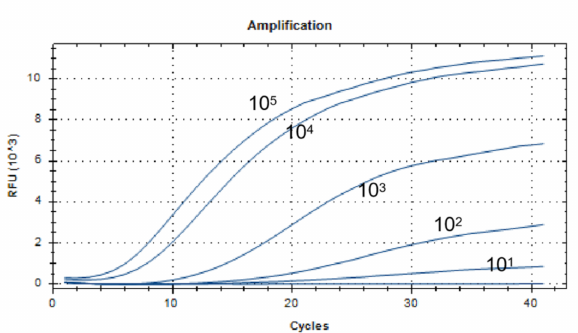
Figure 3. Sensitivity analysis of the real-time RT-RAA assay. The dilution range of the PEDV-N gene plasmid was 10 1 to 10 5 copies/ µ L, and the lowest detection line was 10 1 copies/ µ